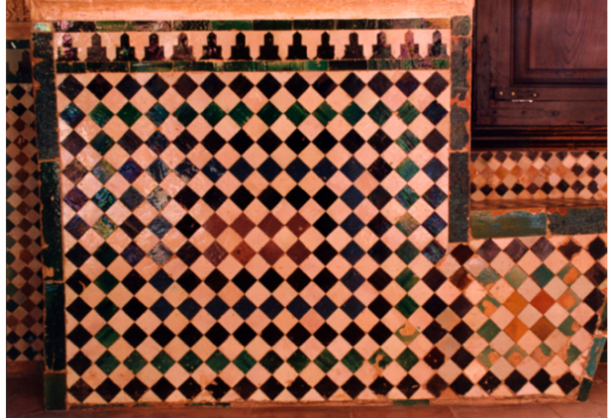
Figure 17. Alicatado panel on the north wall of the Cuarto Dorado in 1994. © Archivo del Patronato de la Alhambra y Generalife, Photograph Collection, F-14590.